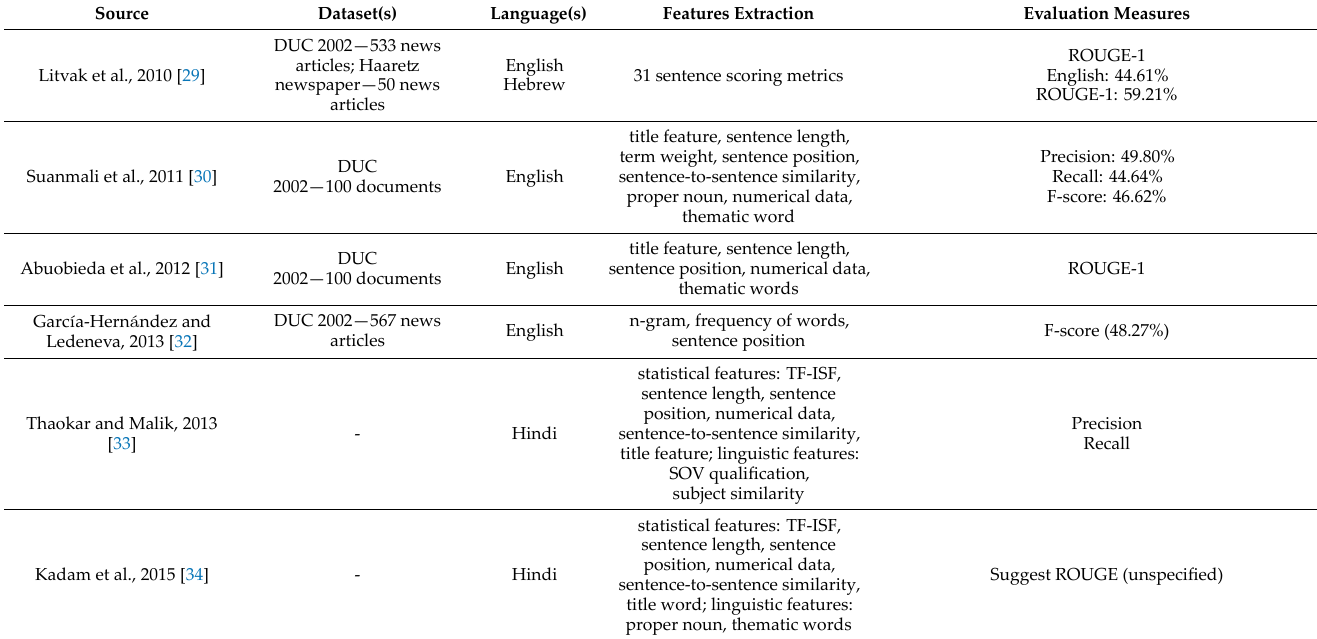
Table 1. Genetic algorithm based extractive text summarization